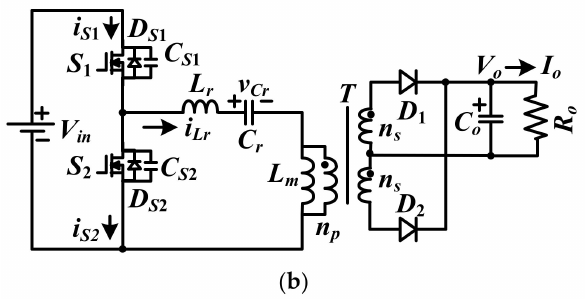
Figure 1. Structures of the conventional LLC converters: ( a ) full bridge LLC structure; ( b ) half